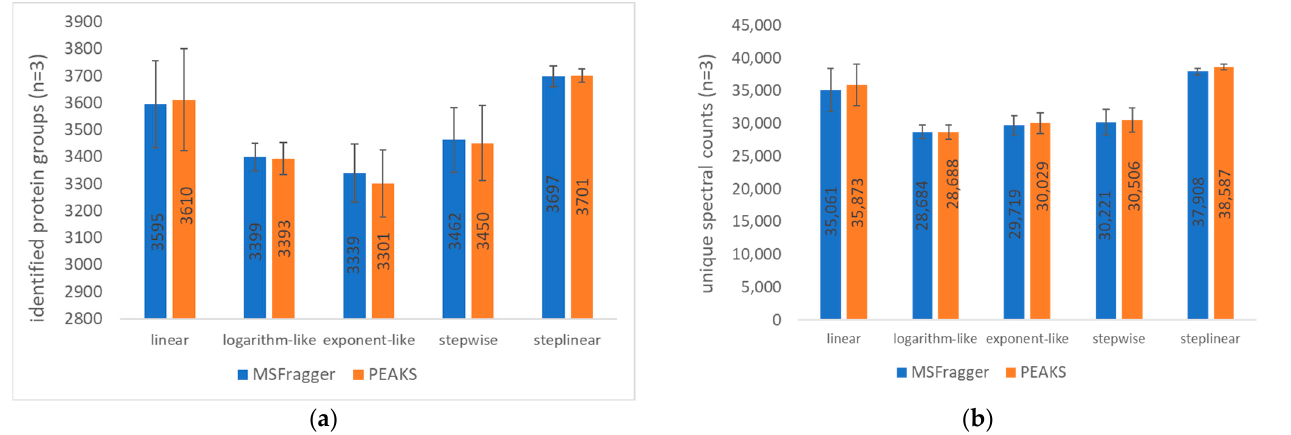
Figure 1. Comparison of the 44 min gradient types and search engines. MSFragger and PEAKS Studio were used to search data from a 100 ng HeLa digest on-column loading. ( a ) Number of identified protein groups; ( b ) number of unique spectral counts. The mean and standard deviation of triplicate injections are shown for each of 5 gradient types by search engines.